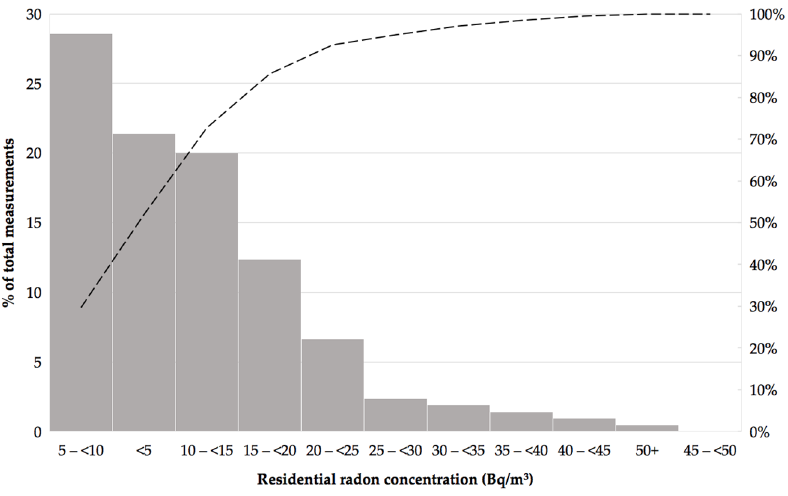
Figure 3. Residential 222 Rn concentrations in Manizales, Colombia. January to June 2020.